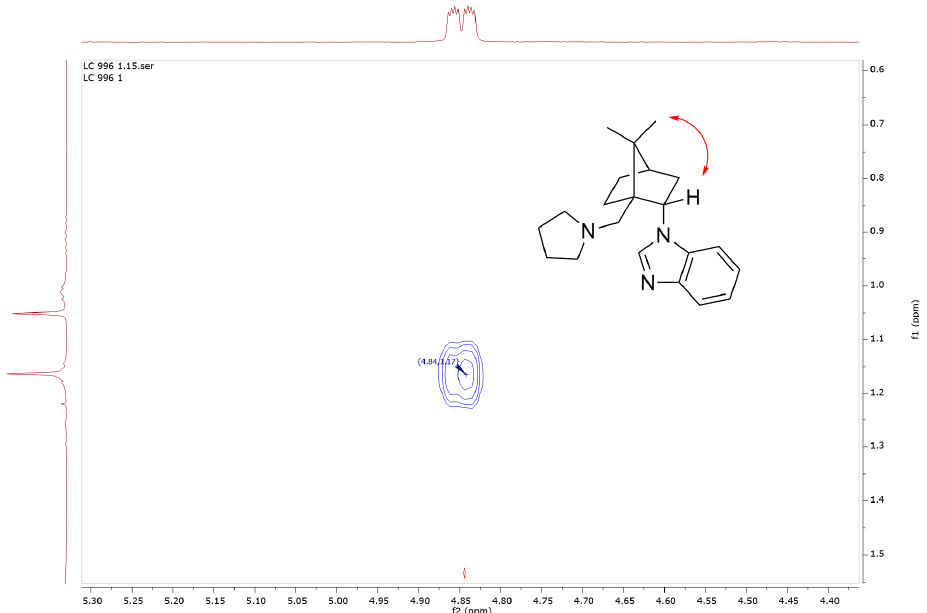
Figure 1. Section of the NOESY spectra of camphor derived benzo[ d ]imidazole 5 displaying the cross-peak between the methyl group and the exo -H(2) proton.